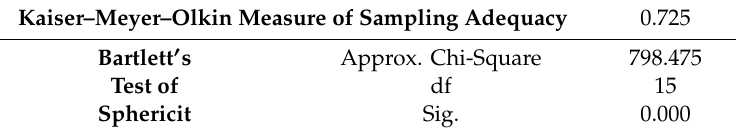
Table 1. Kaiser–Meyer–Olkin (KMO) and Bartlett’s test results. Df:, Sig.: